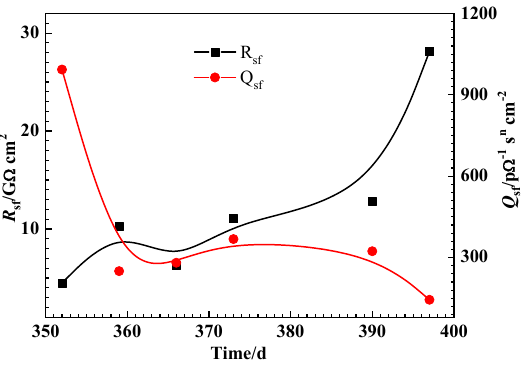
Figure 7. The changes of R sf and Q sf at the substrate / primer interface for the SAP-MRP coated samples as a function of immersion time in the simulated acid rain solution.